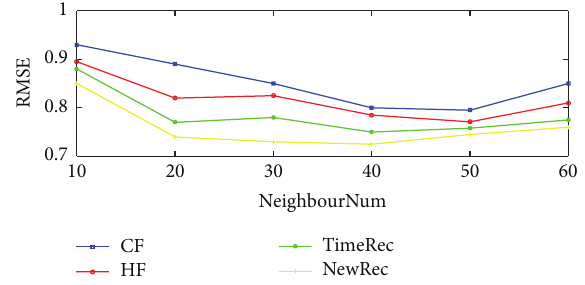
Figure 7: Comparison among different algorithms on